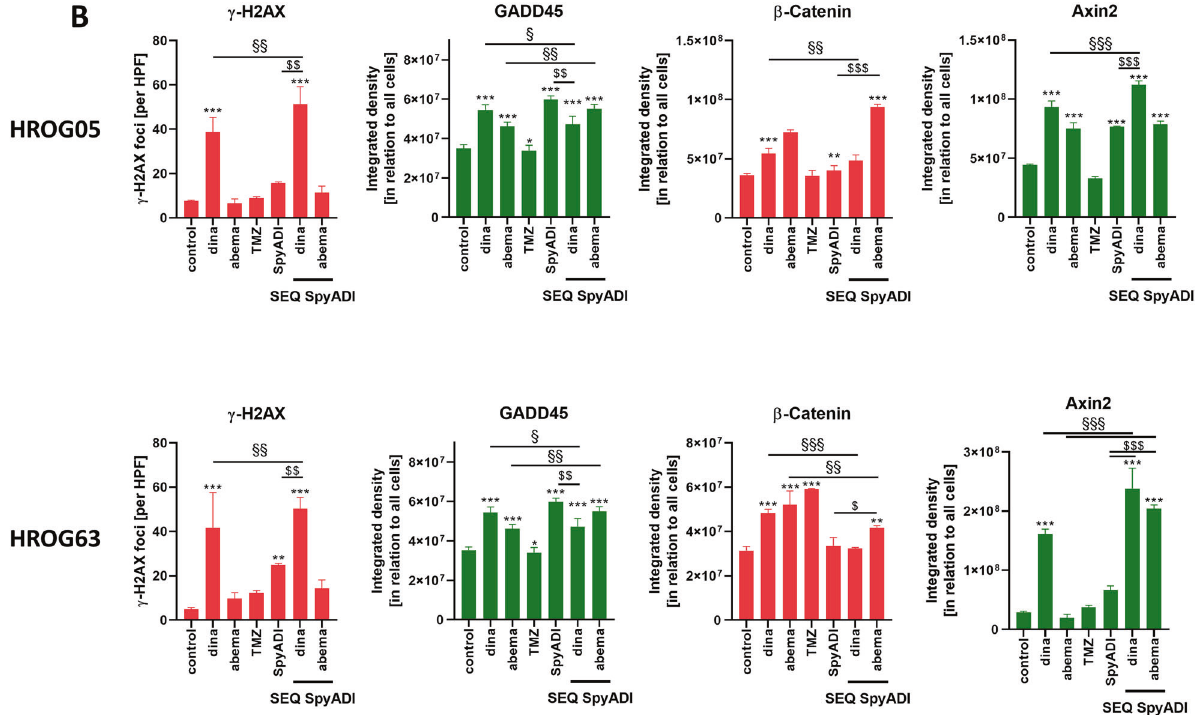
Fig. 6 DNA-damage analysis using immuno fl uorescence and western blot. A Representative images of 2D-cultured GBM cells (HROG05, HROG63), treated with test substances for 2 × 72 h or left untreated. Cells were stained with the following monoclonal antibodies: anti-H2A.X Phospho (Ser139) [red], anti-GADD45 [green], anti- β -catenin [red], and anti-Axin22. For the latter, Axin2, a secondary DyLight 488-conjugated anti-rabbit antibody was applied [green]. Scale bar as indicated: 50 µm. Nuclei were counterstained with DAPI. Images were taken on a Zeiss Elyra 7 Confocal Laser Microscope. B Quanti fi cation of speci fi c markers. n = 3 independent experiments; *** p < 0.001; §§ p < 0.01; $$ p < 0.01. One-way